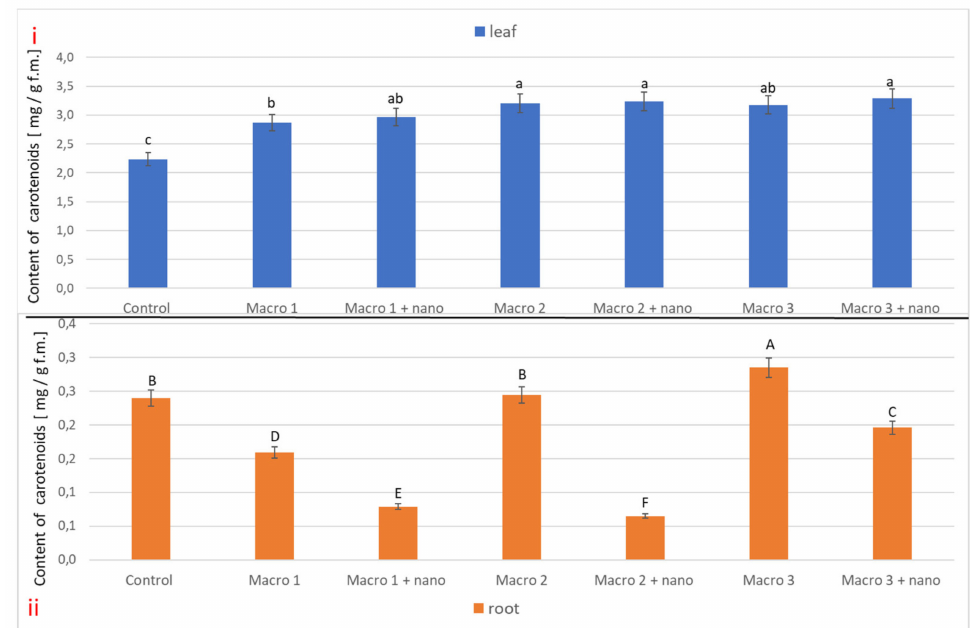
Figure 6. The content of carotenoids [mg g − 1 fresh weight] in the shoots ( i ) and roots ( ii ) of plants grown in soil supplemented macronutrients or macronutrients and nanoparticles. Vertical bars represent the mean values (n = 5) ± standard deviations. Different letters indicate significant difference at p < 0.05 by LSD